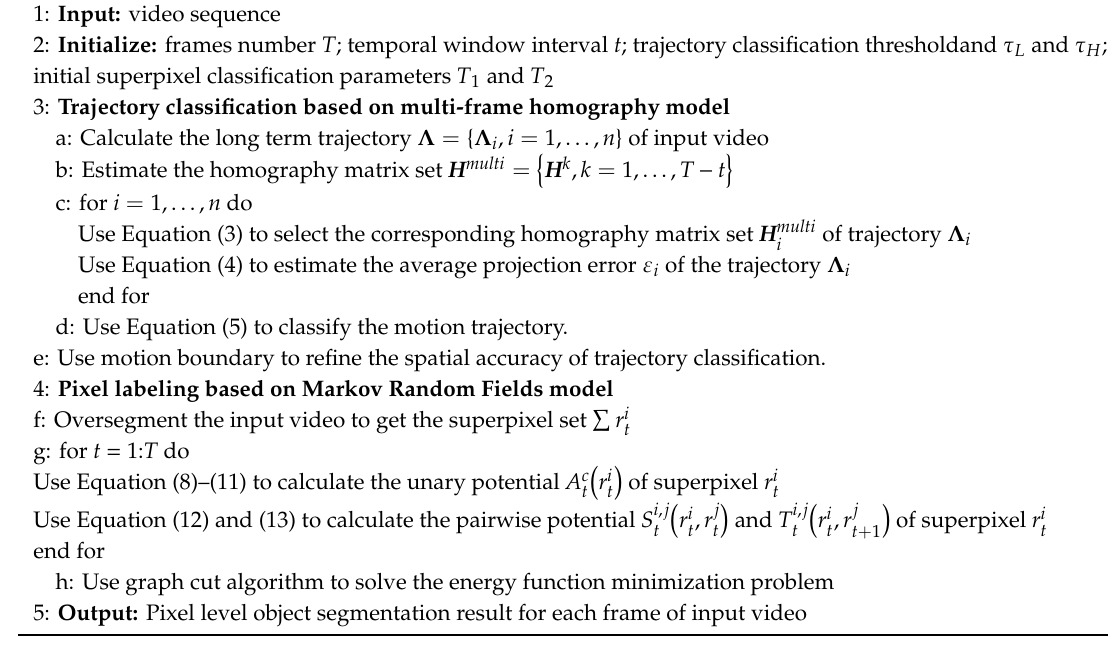
Algorithm 1 Video segmentation algorithm based on multi-frame homography